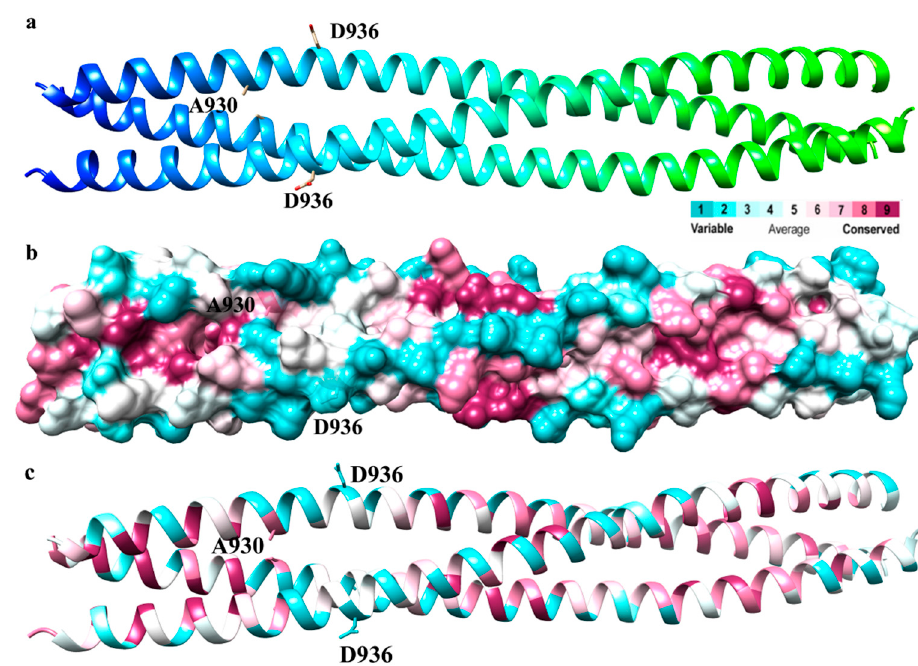
Figure 1. Ribbon structure and conservation of SARS-CoV-2 HR1 domain. ( a ) Ribbon structure of WT SARS-CoV-2 HR1 domain is shown from N terminus (blue) to C terminus (green). ( b ) Conservation plot of WT HR1 domain of SARS-CoV-2. ( c ) Conservation mapped onto ribbon diagram of WT SARS-CoV-2 HR1 domain. Magenta and pink residues indicate strongly or moderately conserved, respectively. Cyan and light blue represent highly or slightly variable, respectively. White indicates regions that are not conserved or